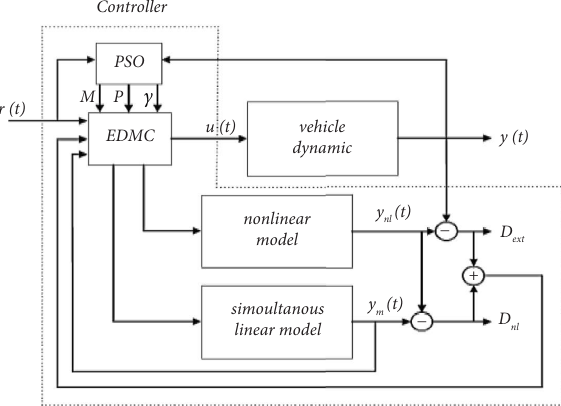
Figure 3: Scheme of EDMC tuned by PSO.